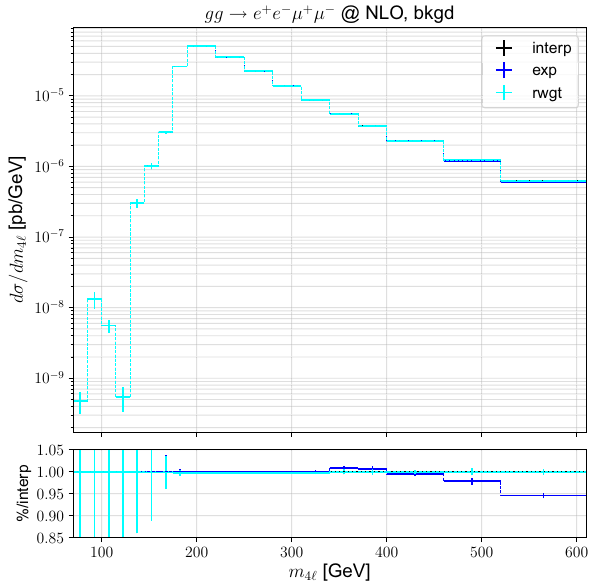
Fig. 14 Differential distribution in invariant mass m 4 (cid:3) of the four- lepton system in gg → e + e − μ + μ − at fixed-order NLO for the background contribution. The upper panel shows nominal predictions obtained using different approximations for the two-loop amplitude: 1 / m t expansion (exp, blue), reweighting with the exact one-loop ampli- tude (rwgt, cyan), and an interpolation between the two options (interp, black). The ratio plot shows the relative yield of the different contribu- tions with respect to the interpolated